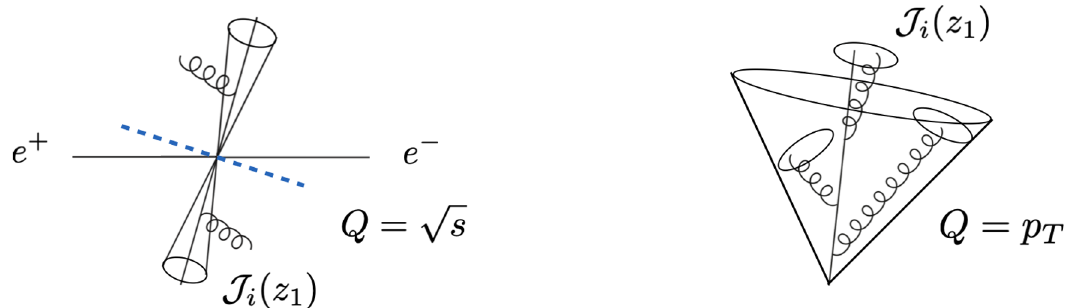
Figure 4 . Illustration of e + e − hemisphere leading jets (left) and leading subjets (right).